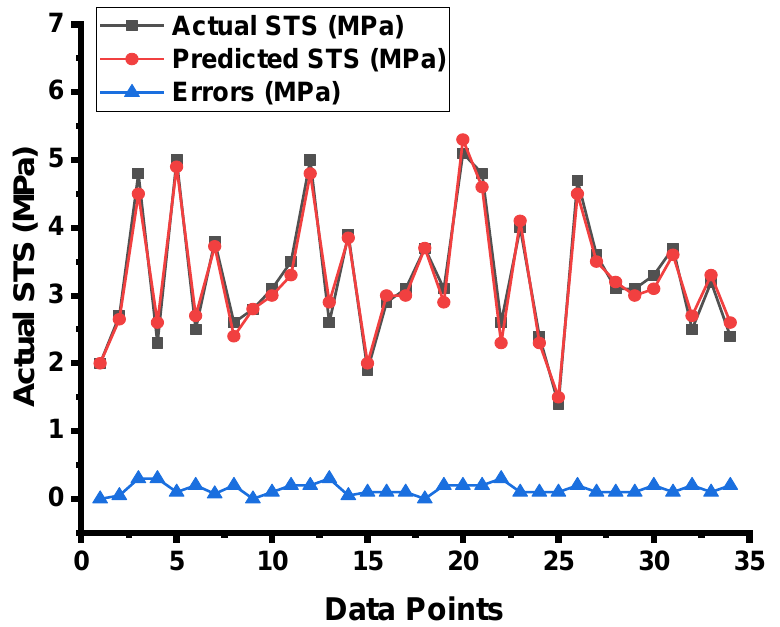
Figure 12. RF model ’s actual results, predictions, and dispersal of their difference.